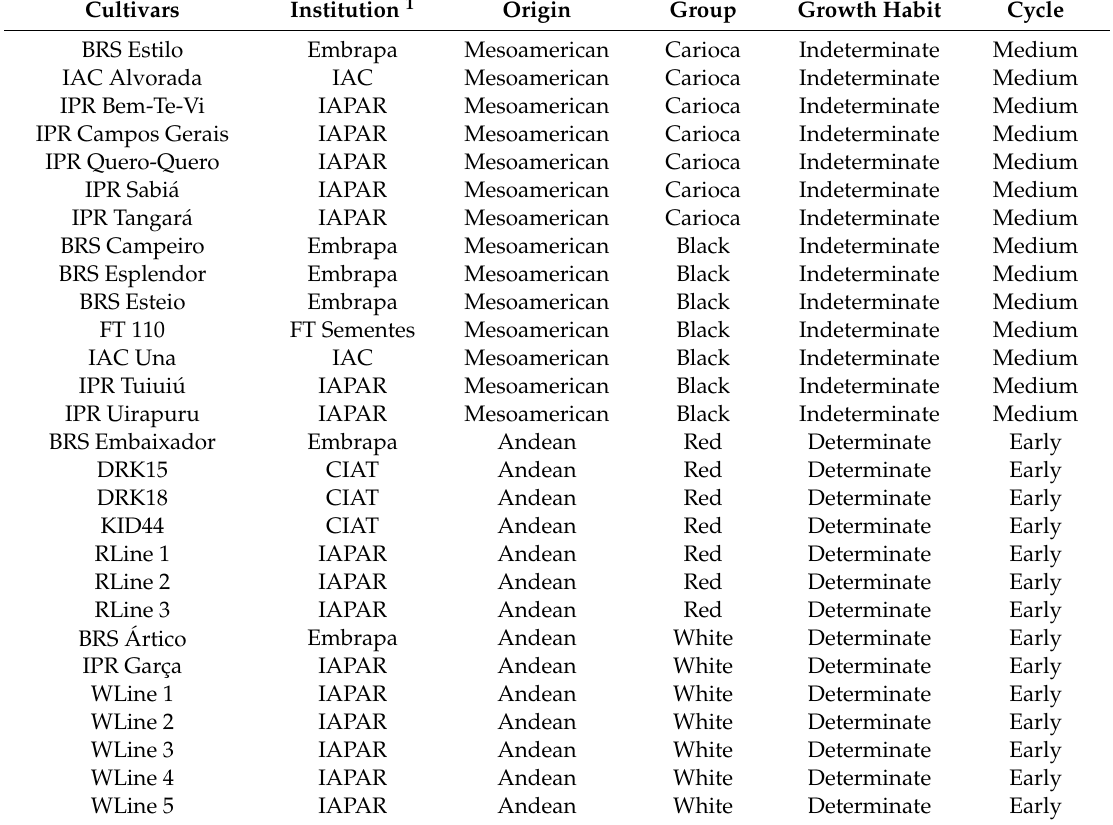
Table 2. List of Mesoamerican and Andean genotypes evaluated under Al